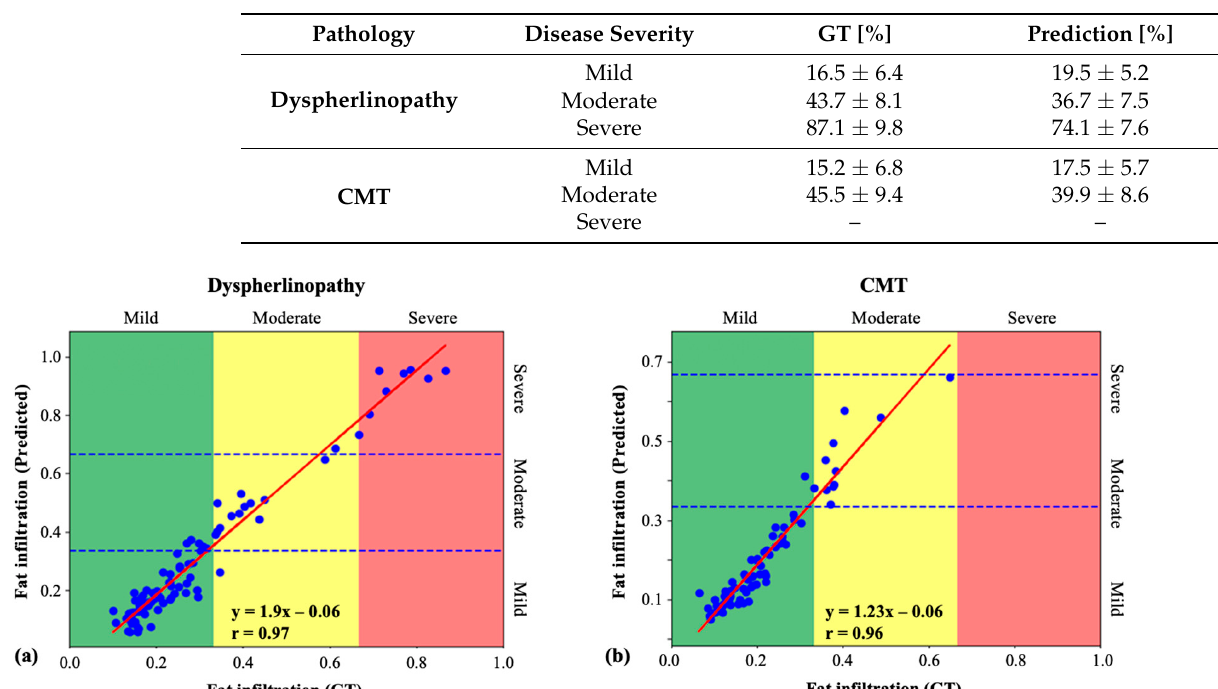
Table 3. Evaluation of ground-truth vs. FCN-based quantification fat infiltration for patients suffering from mild, moderate, and severe dysferlinopathy and CMT diseases.